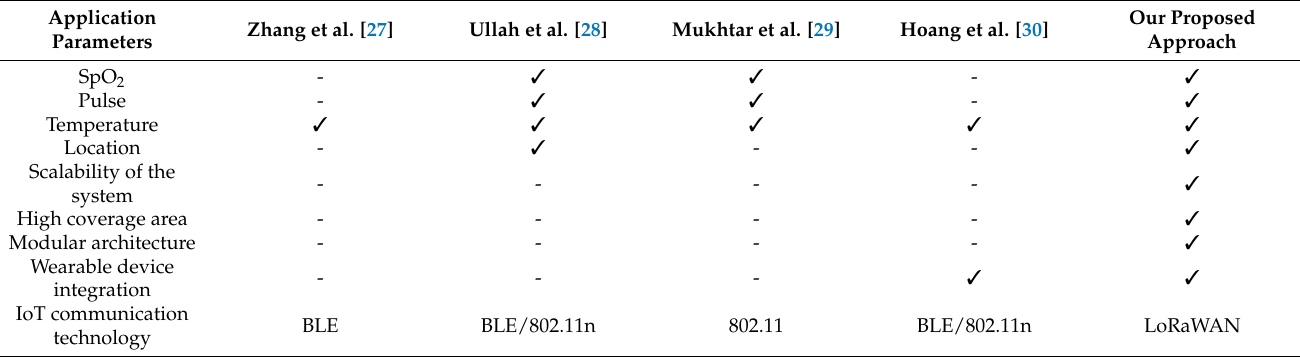
Table 3. Performance evaluation of the developed system compared with other